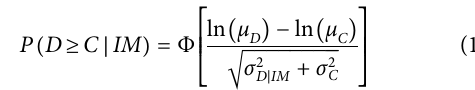
Frontiers in Physics |